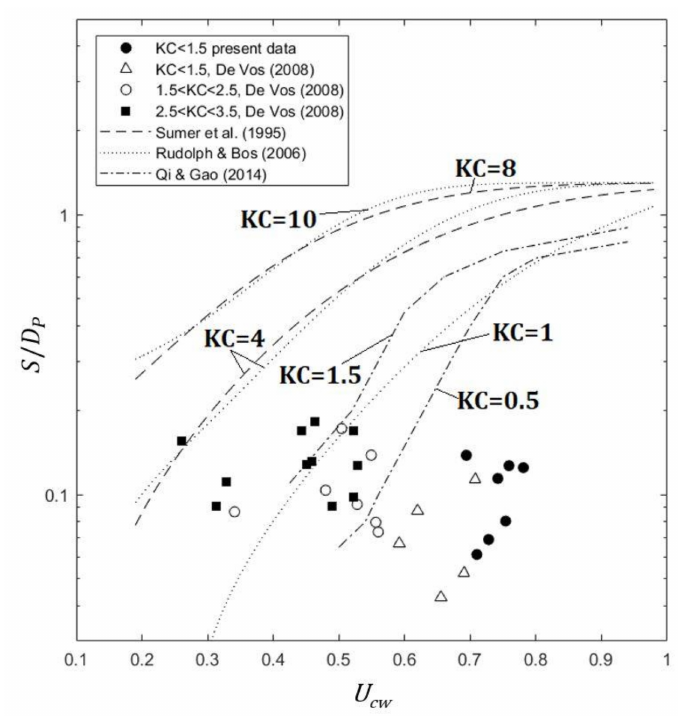
Figure 17. Relation between S / D P and U cw for various KC numbers after 3000